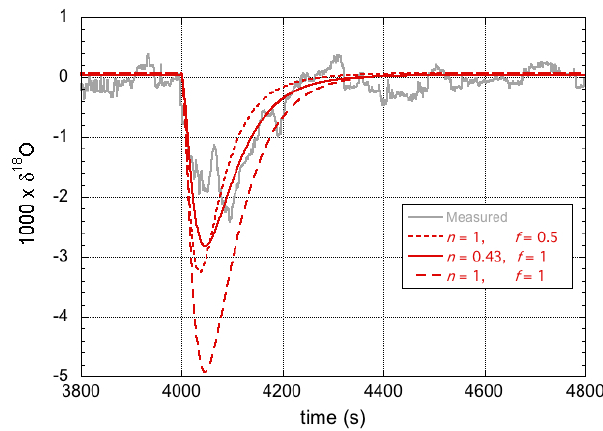
Figure 6. Experimental data and model simulations of the 18 O re- sponse curves for two different values of α eff and two different val- ues of f